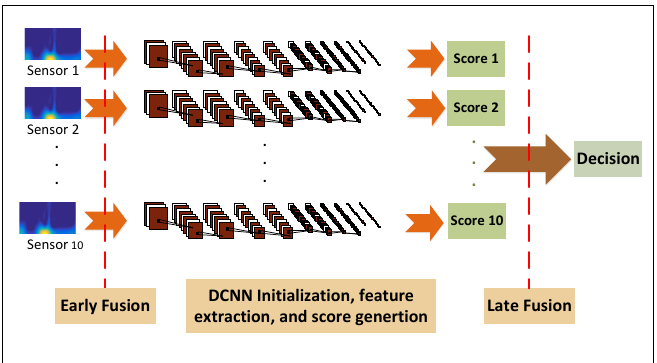
Figure 7. block diagram for early and late score